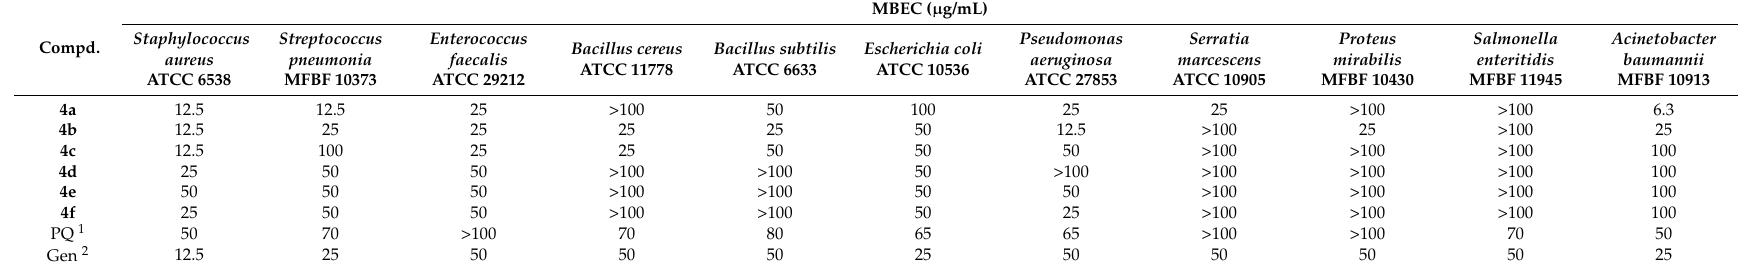
Table 2. Sensitivity of microbial strains to fumardiamides 4a – f expressed as minimum biofilm eradication concentrations (MBEC).